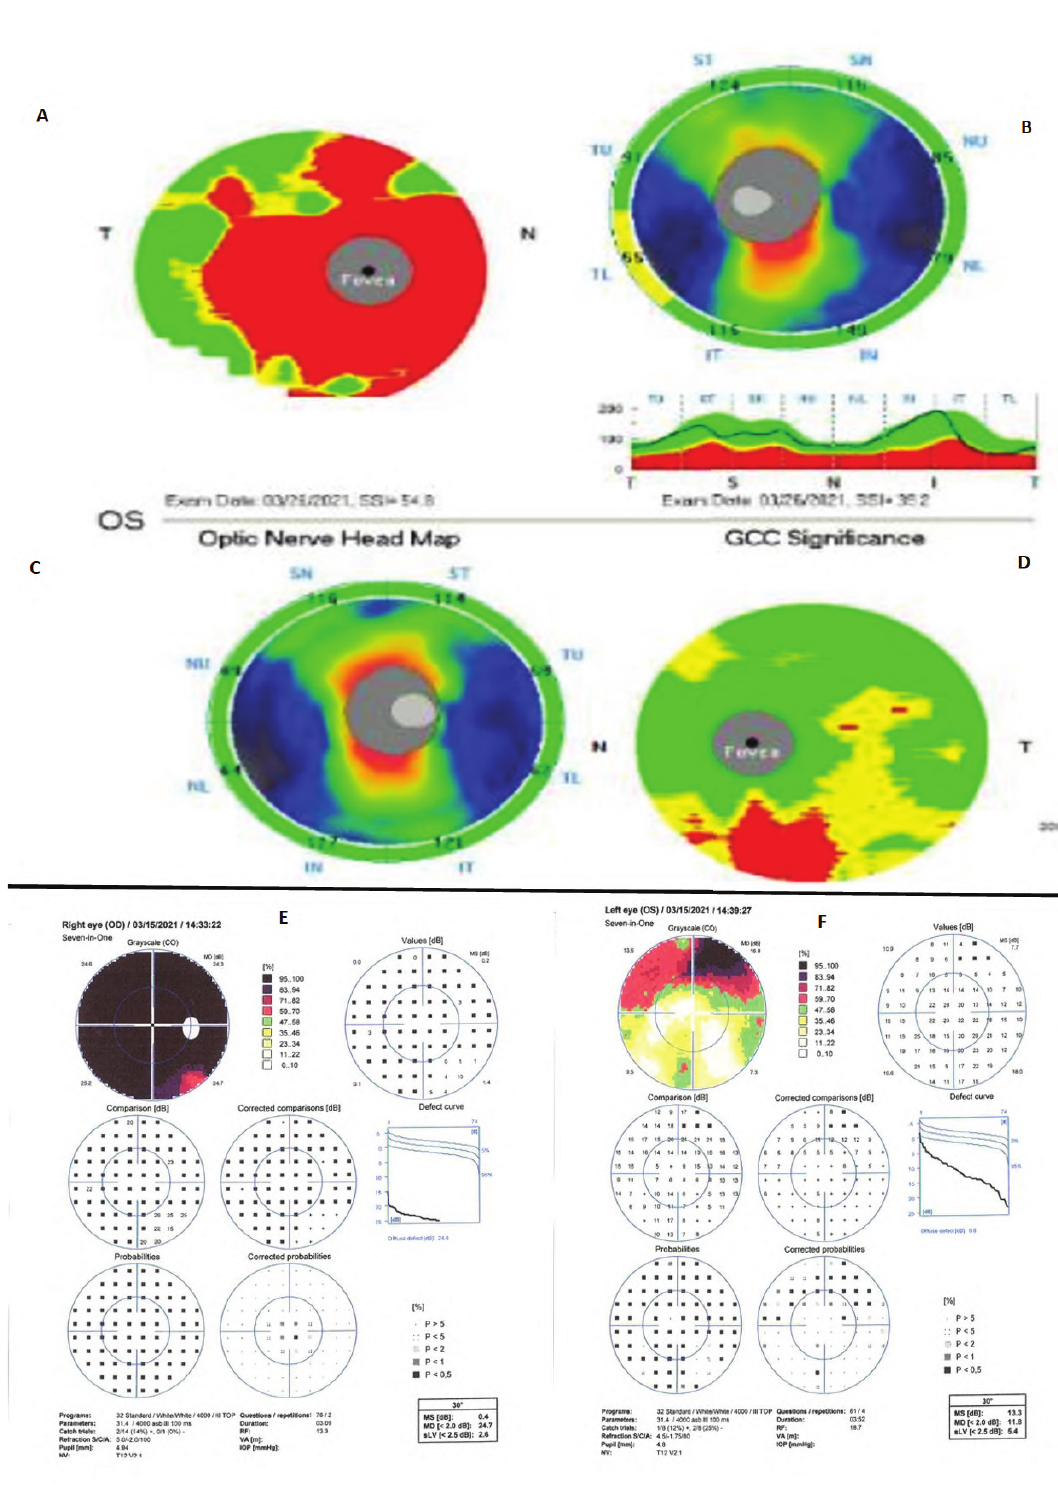
Figure 2. A and B illustrate ganglion cell complex (GCC) and retinal nerve fiber layer (rNFL) thickness of the right eye, respectively. GCC image demonstrates significant thinning (red area), and rNFL looks normal. C and D show rNFL thickness and GCC of the left eye, respectively. GCC image demonstrates thinning inferiorly (red area) and rNFL looks normal. E and F are Octopus EyeSuite 𝑇𝑀 Static perimetry V6.3.1 visual field of the right and left eyes, respectively. Right eye visual field shows severe generalized depression, and the left eye depicts a superior altitudinal